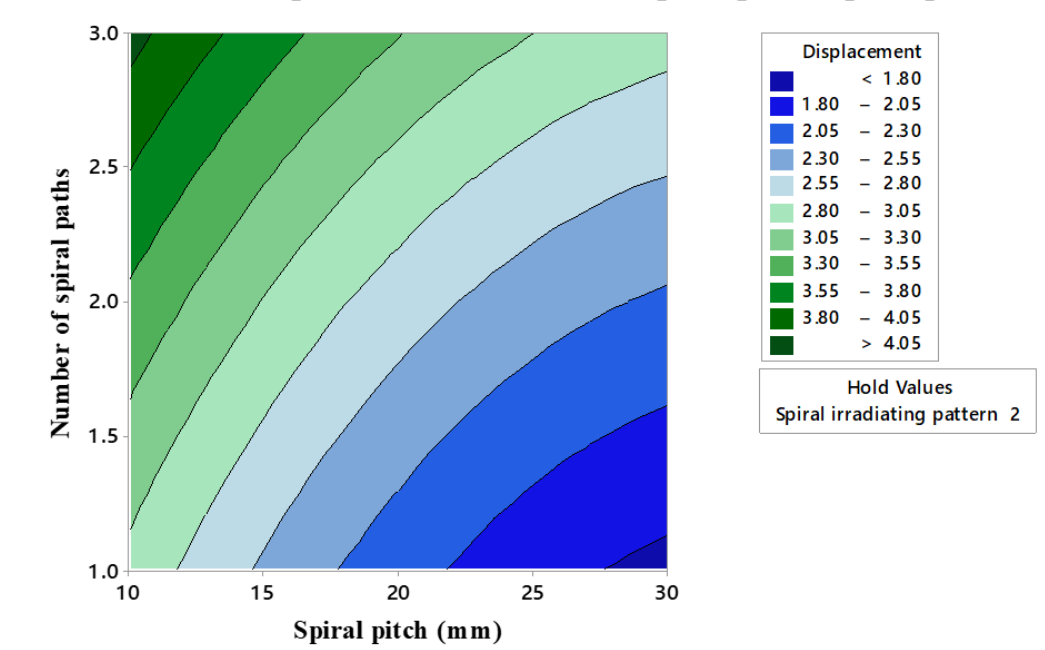
Figure 4. The interaction of spiral pitch and the number of spiral passes on the displacement of sample point